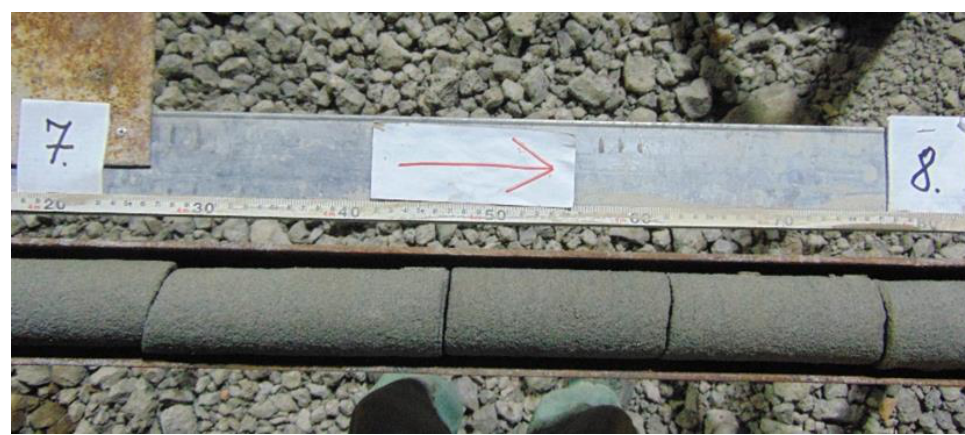
Figure 6. Upper Pannonian sandstone core retrieved from well “SZT - 1” at depth interval of 1970.7–1971.3 m.